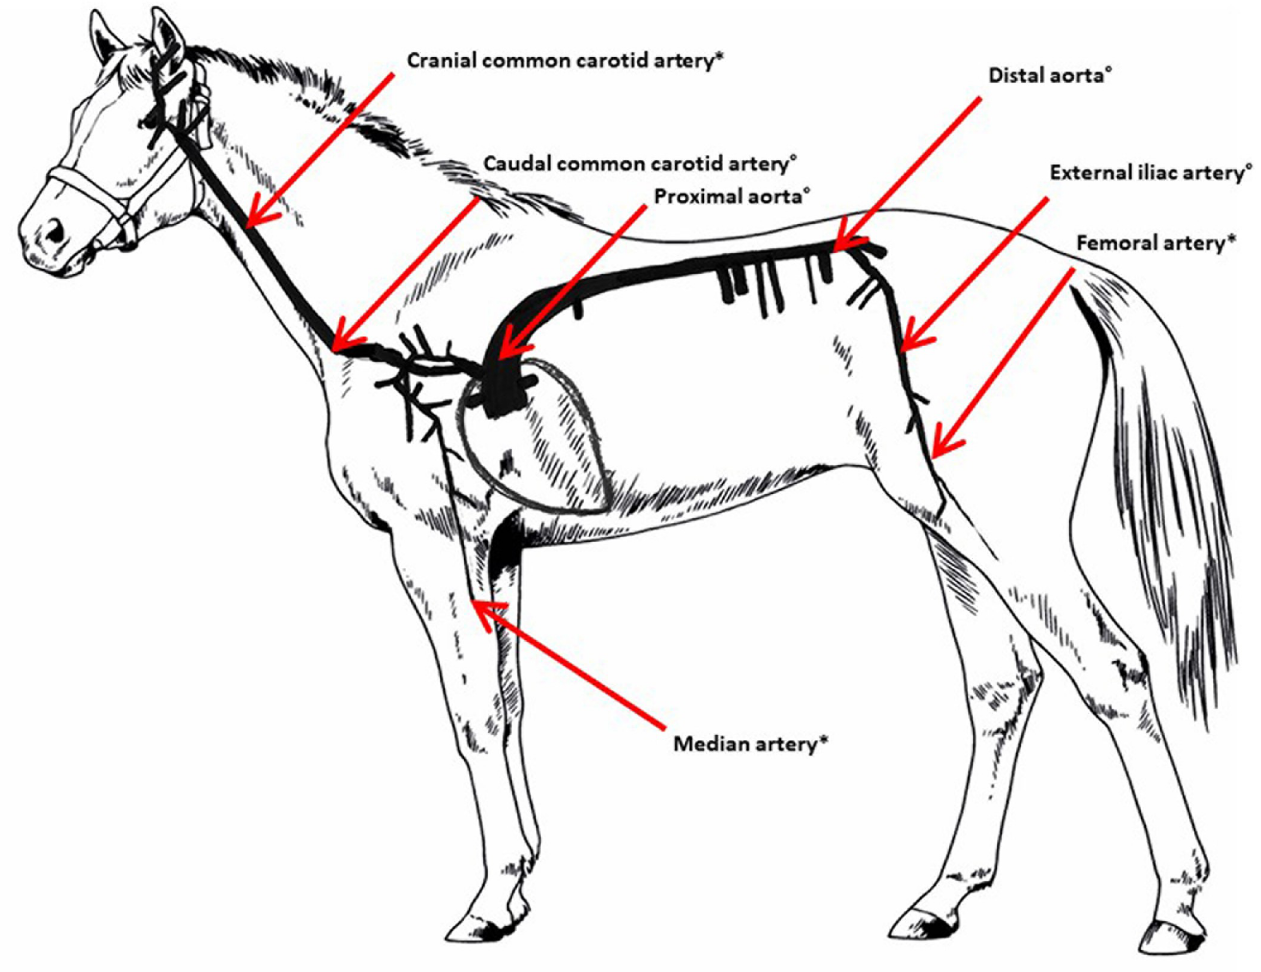
Fig 1. Schematic overview of the locations at which samples were collected. � : samples of 14 old and 6 young horses were collected for histology. ˚: samples of 14 old and 6 young horses were collected for histology and biomechanical testing.